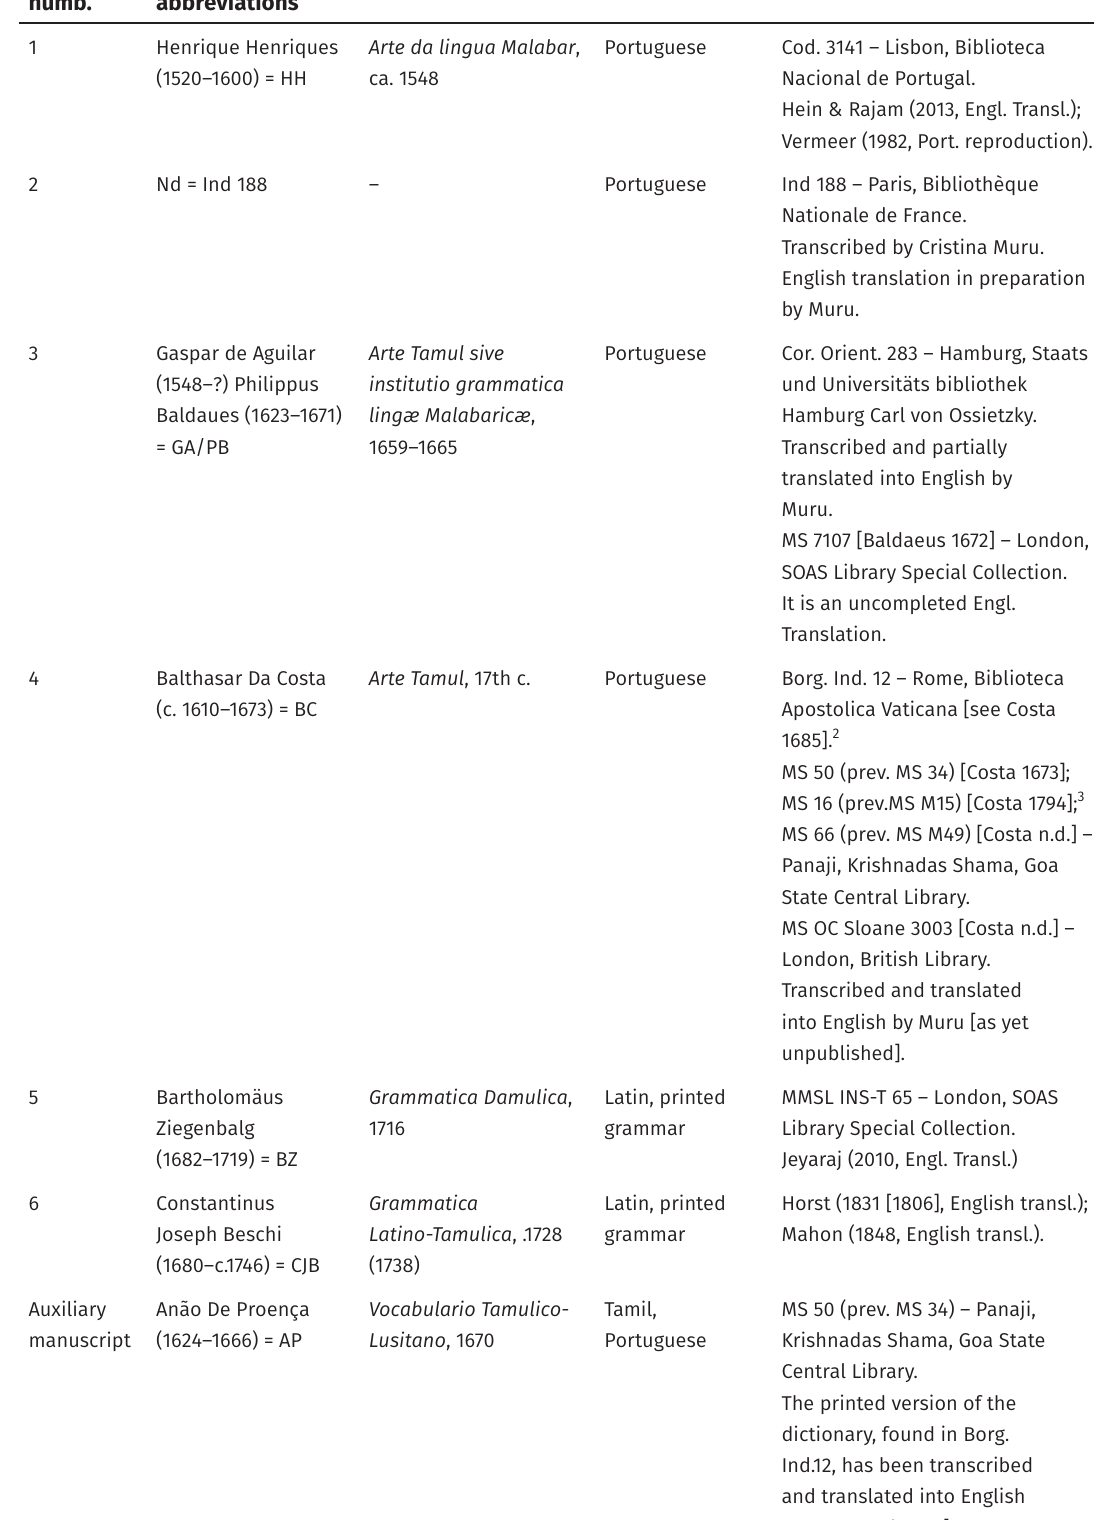
Table 1: List of analysed documents.